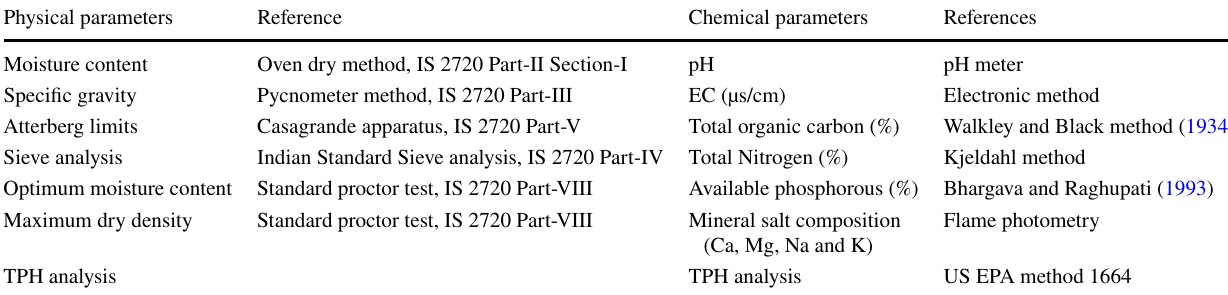
Table 1 Procedure adopted for analyzing soil physical and chemical properties Physical